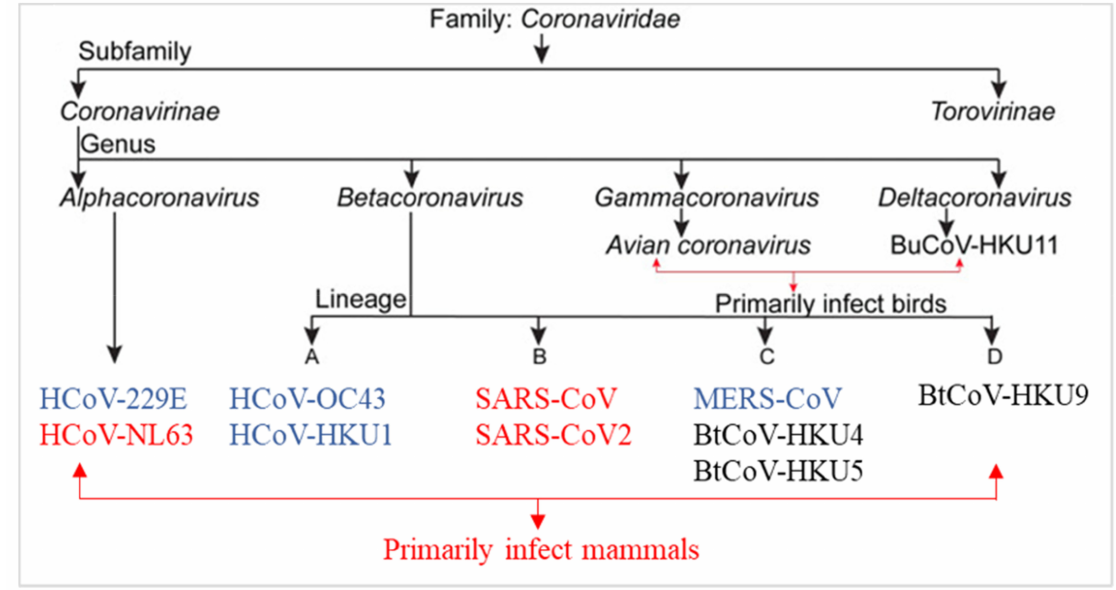
Figure 1. Classification of coronaviruses: the seven known HCoVs are in blue and red. Human coronaviruses (in red) bind the same host receptor, angiotensin-converting enzyme 2